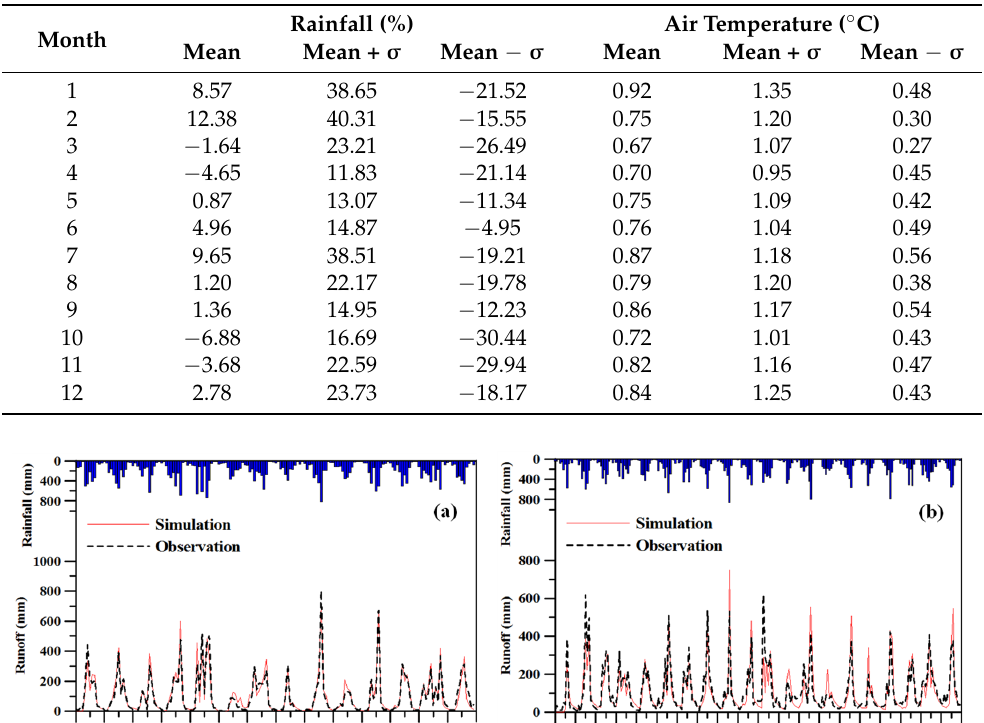
Table 5. Representative future climate variations of rainfall and air temperature in the Choushui River watershed.